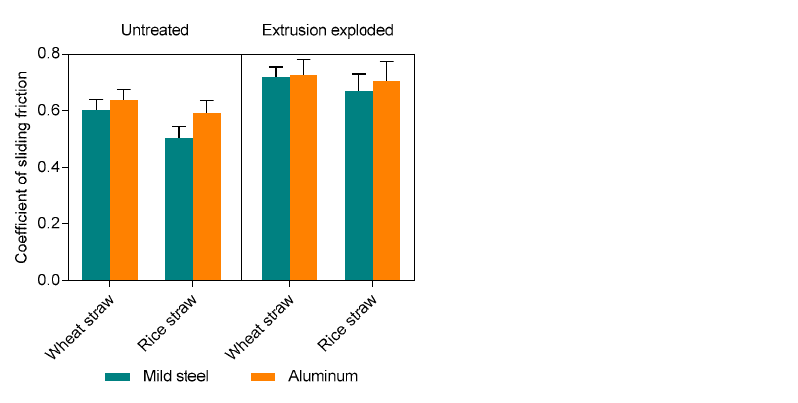
Figure 3. Comparison of the means of coefficients of the sliding friction between untreated and extrusion-exploded straw, wheat straw and rice straw, and mild steel and aluminum surfaces.